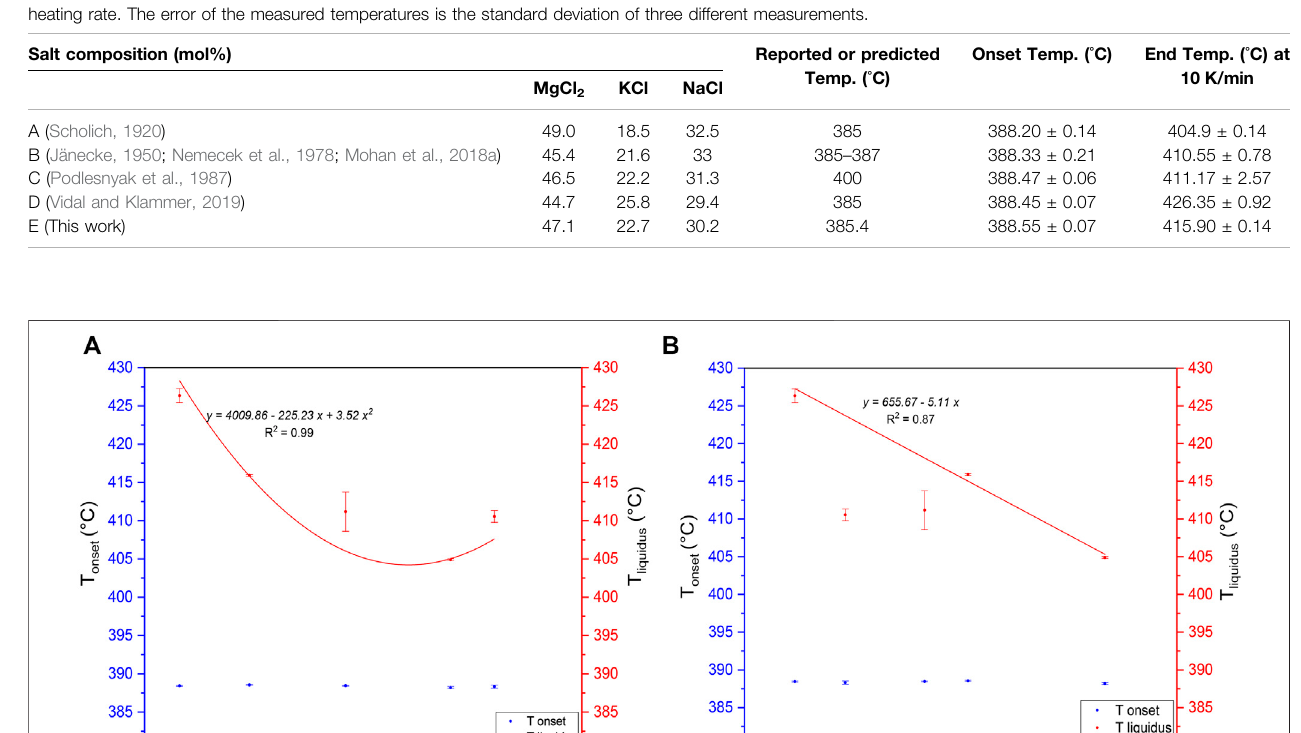
fi ve different ternary mixtures at 10 K/min are shown in Figure 6 , in which the in fl uence of each single chloride from the ternary mixture is notable. Both NaCl and MgCl 2 contribute to a decrease in the liquidus temperature, whereas the KCl content increases the liquidus temperature. The